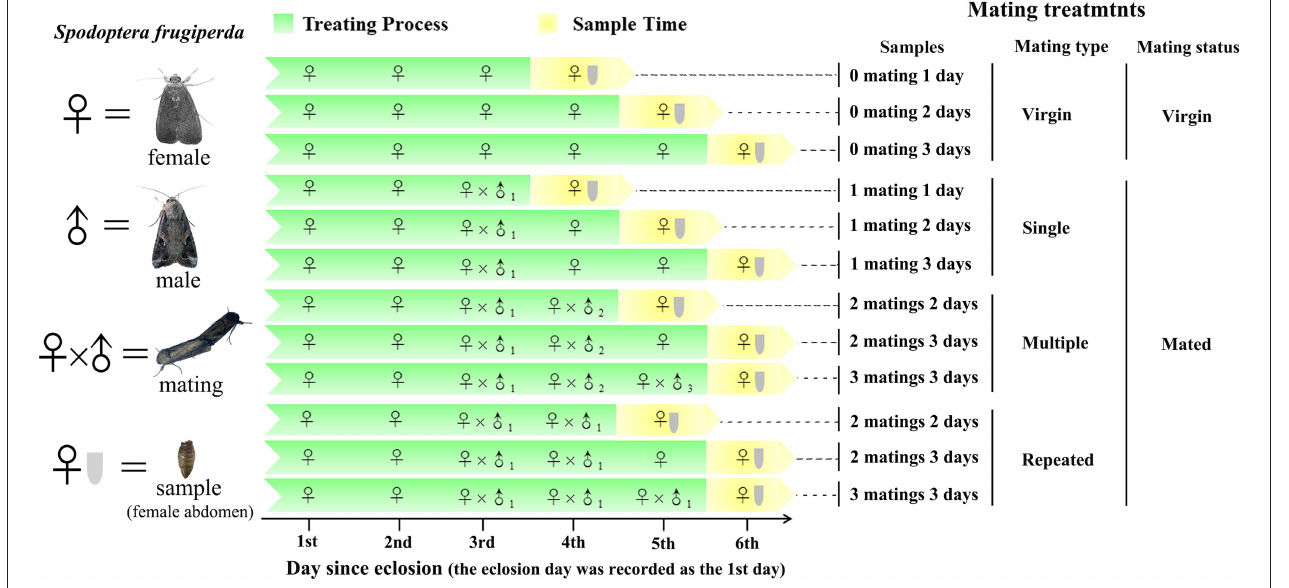
FIGURE 1 | Experimental design and sampling methods. Single refer to one-time mated females, in which 1 mating 1 day ( n = 3), 1 mating 2 days ( n = 3), and 1 mating 3 days ( n = 3) refer to one-time mated females sampled at 1, 2, and 3 d postmating (since the first mating), respectively. Multiple refer to females mated with multiple males (one male one mating), in which 2 matings 2 days ( n = 3), 2 matings 3 days ( n = 3), and 3 matings 3 days ( n = 3) refer to twice and thrice mated females sampled at 2 and 3 d postmating (since the first mating), respectively. Repeated refer to females mated repeatedly with the same male, in which 2 matings 2 days ( n = 3), 2 matings 3 days ( n = 3), and 3 matings 3 days ( n = 3) refer to twice and thrice mated females sampled at 2 and 3 d postmating (since the first mating), respectively. Virgin refer to unmated females, in which 0 mating 1 day ( n = 3), 0 mating 2 days, and 0 mating 3 days ( n = 3) refer to virgin females sampled at 1, 2, and 3 d postmating (relative to the above mating treatments),